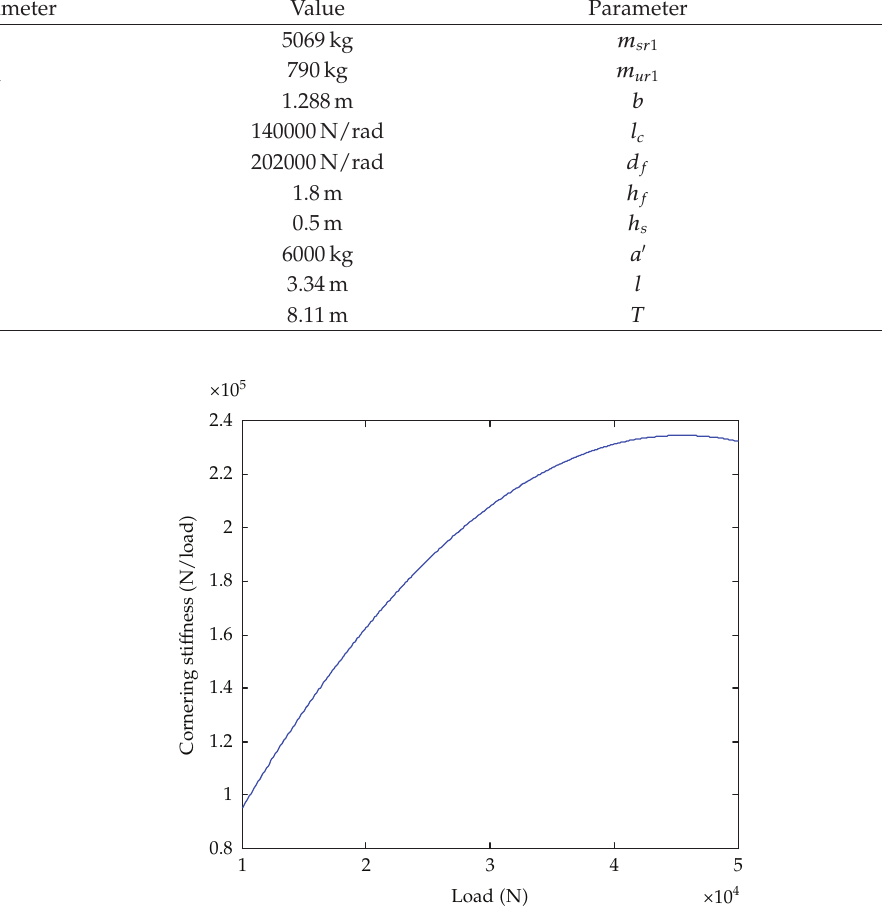
Figure 4: Tire cornering sti ff ness as a function of vertical